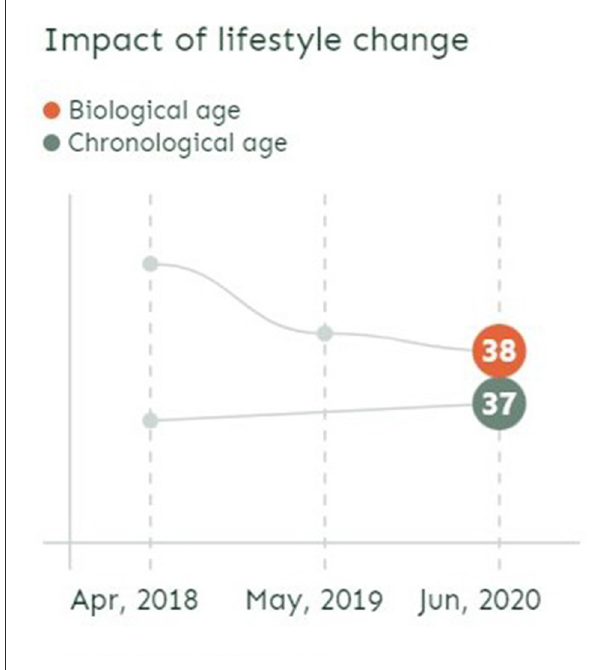
FIGURE2 Screenshot from GlycanAge website illustrating the possibility to change biological age over time (November